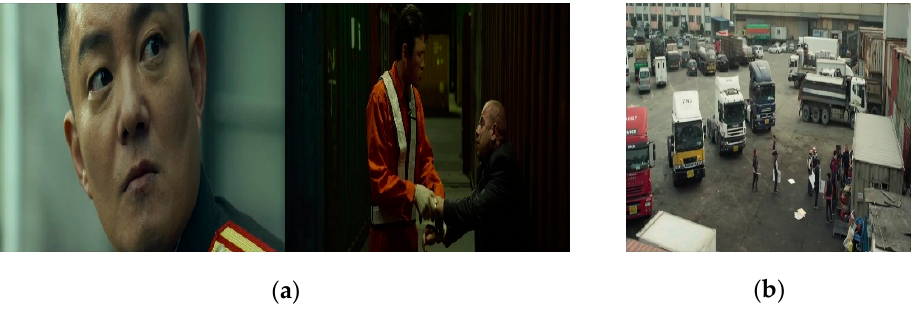
Figure 2. ( a ) Shots with faces; ( b ) a shot without a visible face.